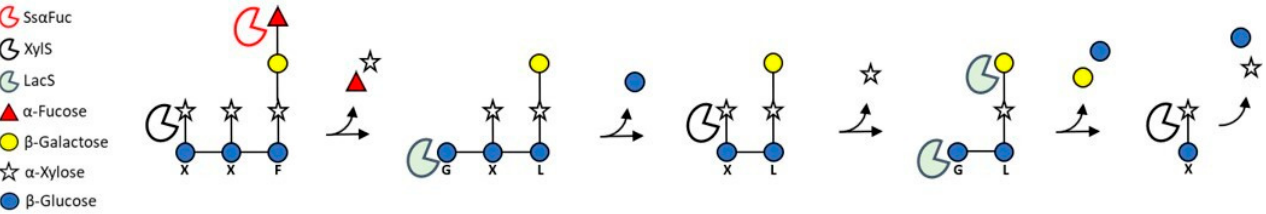
Figure 4. Proposed model of the reaction mechanism on XGOs by XylS, Ss α Fuc and